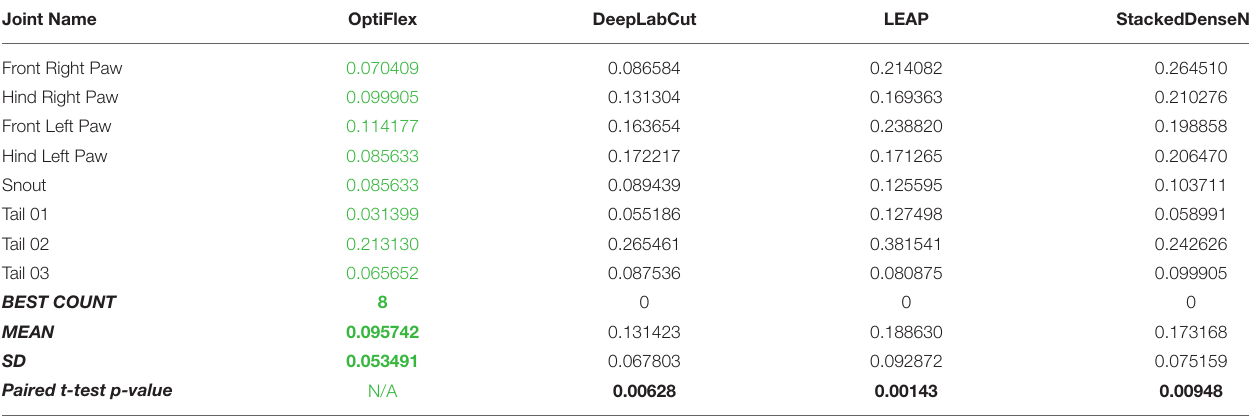
TABLE 1 | Comparison of OptiFlex with previous frameworks on mouse side-view dataset.